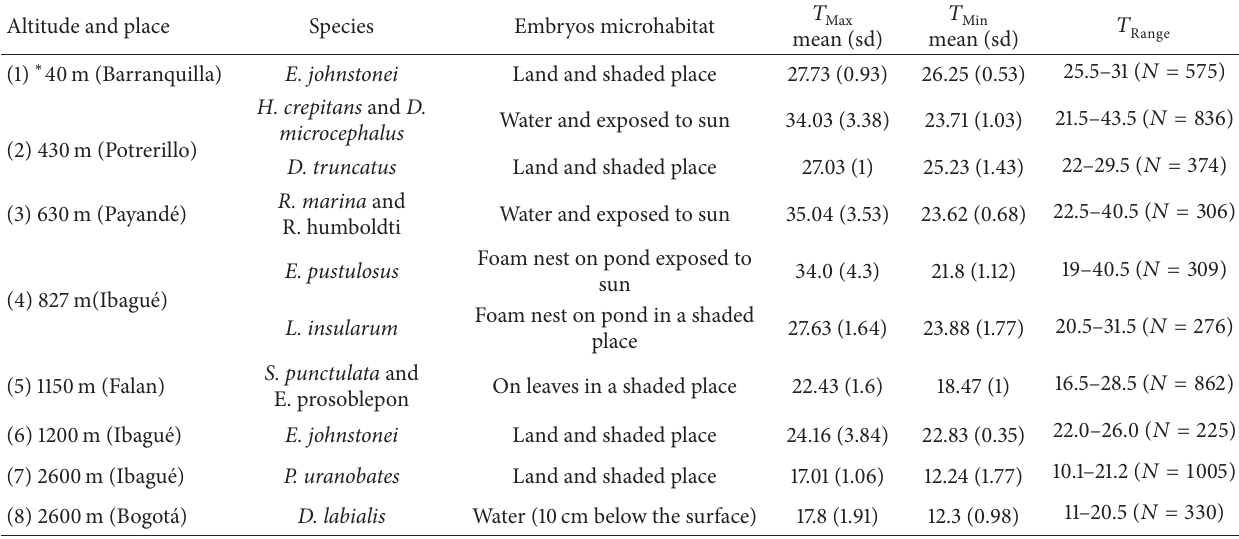
Table 2: Daily microhabitat temperatures for the study species. Altitude and